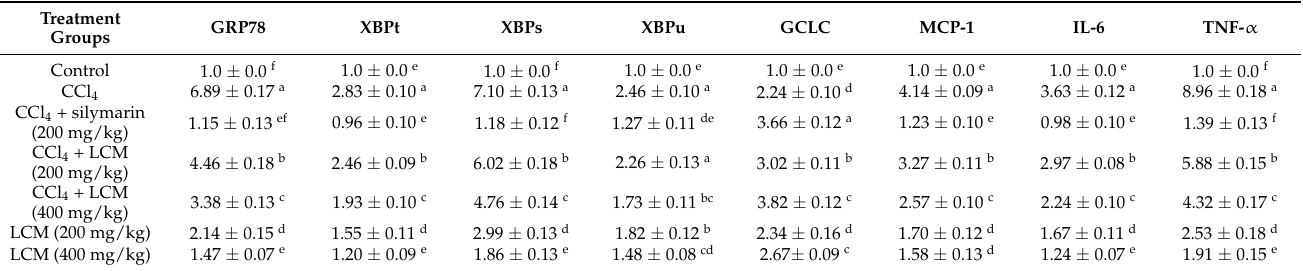
Table 8. Effect of different treatments with L. corymbulosum on fold changes of various genes involved in CCl 4 -induced ER